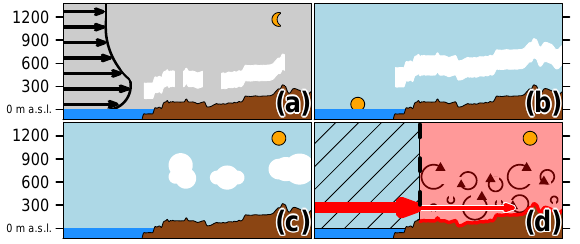
Figure 2. Schematic view of SWA atmospheric dynamics via a meridional–vertical transect (ma.s.l.) through the Gulf of Guinea (blue shading) and adjacent land (brown shading). (a) During night- time the NLLJ leads to a wind maximum at about 300ma.g.l. as em- phasized by the black arrows. Over land, NLLS forms at the level of the NLLJ axis. The NLLS establishment occurs around 22:00UTC over Kumasi and 01:00UTC over Savè (Kalthoff et al., 2018). (b) The maximum spatial coverage of NLLS is reached in the morn- ing hours around 09:00 to 10:00UTC. After sunrise (05:30UTC) a lifting of the cloud base height can be observed. (c) During late morning or early afternoon the NLLS deck breaks up to cumuliform clouds (around 11:00UTC over Kumasi and 12:00UTC over Savé; Kalthoff et al., 2018). (d) During daytime (05:30–18:00UTC) the momentum of the onshore monsoon flow (bold red arrow) is mixed vertically over land due to atmospheric turbulence from solar heat- ing (eddies). The balance between the monsoon flow and the turbu- lence leads to a frontal structure inland from the coast (black dashed line).